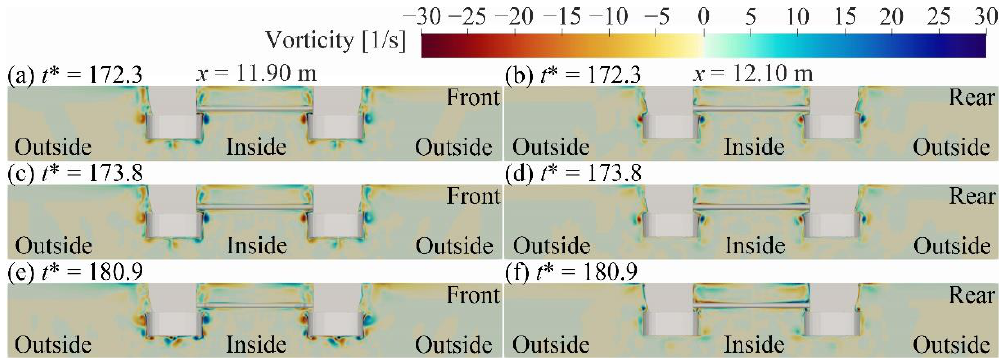
Figure 10. Vorticity around the platform at x = 11.90 m and x = 12.10 m for Case A2.